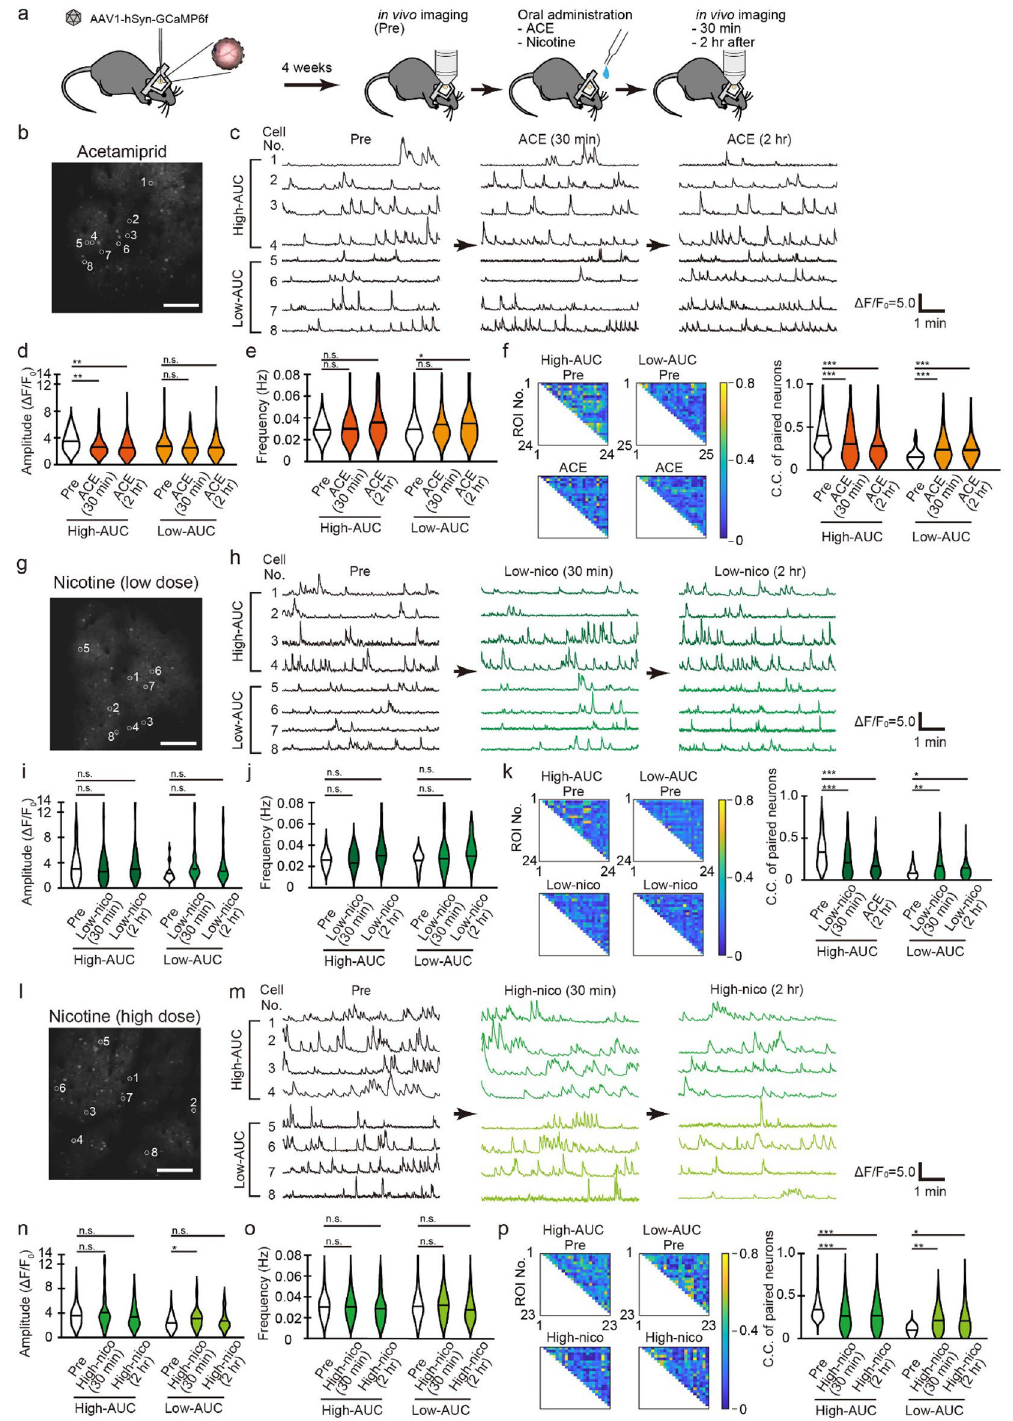
Figure 1. The effect of acute administration of acetamiprid (ACE) (20 mg/kg, p.o.) and low-dose (0.33 mg/kg, p.o.) or high-dose (1.65 mg/kg, p.o.) of nicotine on the neuronal activity in the somatosensory cortex ( a ) A schematic drawing of the experimental procedure for the two-photon microscopy. Wild-type mice have been injected with adeno-associated virus vector-encoding GCaMP6f. into the somatosensory cortex to enable Ca 2+ imaging of neurons. In vivo Ca 2+ imaging has been performed before and after the oral administration of reagents; ( b ), ( g ), and ( l ) Representative images of neurons expressing GCaMP6f. Typical Ca 2+ responses, before and after the administration, recorded from the circled cells and represented in c, h, and m, respectively. Scale bar, 100 μm; ( c ), ( h ), and ( m ) Ca 2+ responses from same neurons; ( d ), ( i ), and ( n ) The amplitude; ( e ), ( j ), and ( o ) frequency of Ca 2+ transient in each group, before and after the administration; ( f ), ( k ), and ( p ) Representative results of correlation co-efficiency for paired neurons. Color-coded maps indicate that the typical neuron sets have responded to each reagent. n.s., not significant. * p < 0.05, ** p < 0.01, *** p < 0.001. Abbreviations: AUC area under the curve, CC cross- correlation, No number, nico